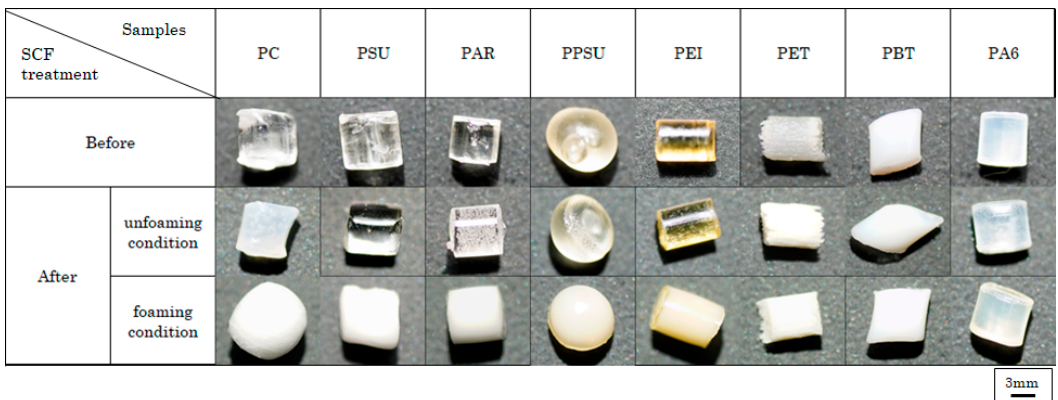
Figure 3. Appearance of pellets formed using di ff erent engineering plastics before and after supercritical treatment.